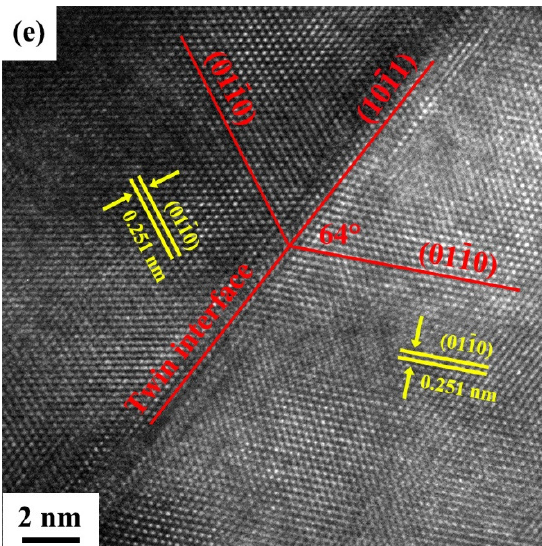
Figure 4. Bright-field TEM images showing the microstructure of Ti-6Al-4V alloy samples made with SLM ( a – c ), where the inserted SADP in ( a , b ) corresponds to the arrowed region on the images and ( c ) shows twins as revealed by the corresponding SADP in ( d ) which is taken from the arrowed region in ( c ), and ( e ) HRTEM image of a twin in the SLM sample.